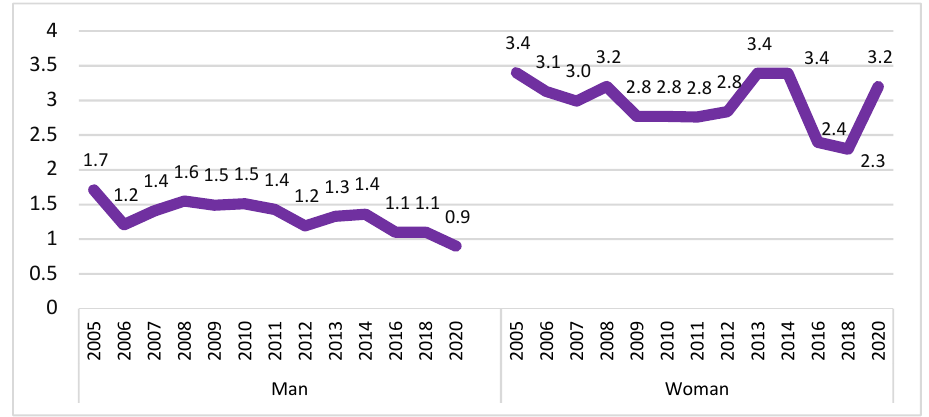
Figure 15. The General Diversity Index based on three weighted positive and three weighted negative statements about diversity—according to gender.